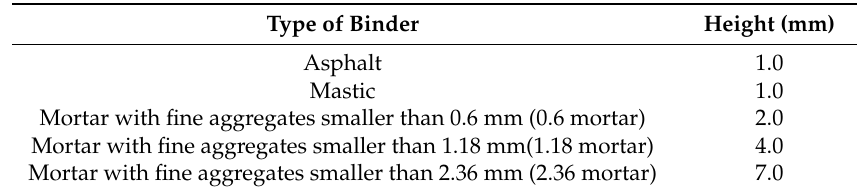
Table 5. Designed height of DSR test